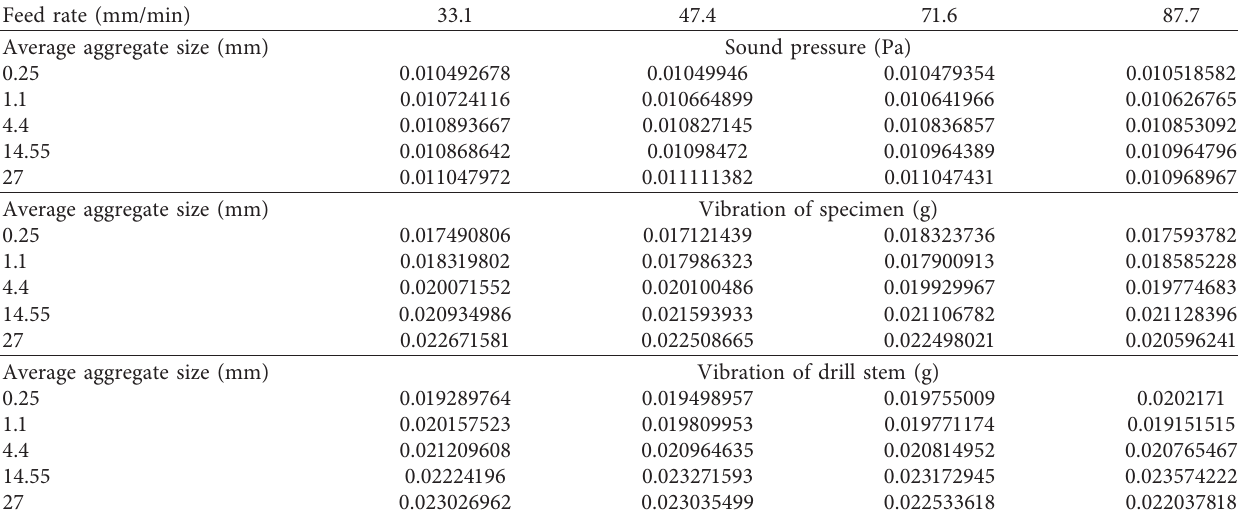
Figure 3: Part of the time-domain waveform of the drilling sound signals of five concrete specimens with different-sized aggregates. Table 3: Sound pressure of